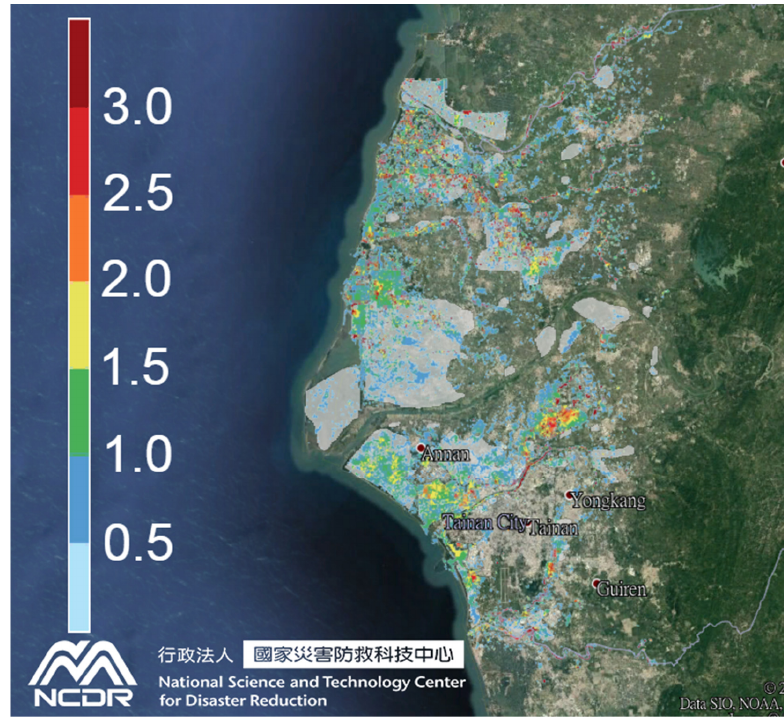
11 of 19 surveyed, while areas with colors represent model hindcasts. The surveyed (white shaded polygons) and hindcasted (areas with colors) flood extents caused by intense rain from Typhoon Morakot in 2009 are illustrated in Figure 10. The hindcasted flood extents were underestimated compared with the surveys in these two large-scale inundation events. The surveyed flooding areas in Tainan city were approximately 303.5 and 616.3 km 2 for the torrential rain event on 12 June 2005 and the intense rain event resulting from Typhoon